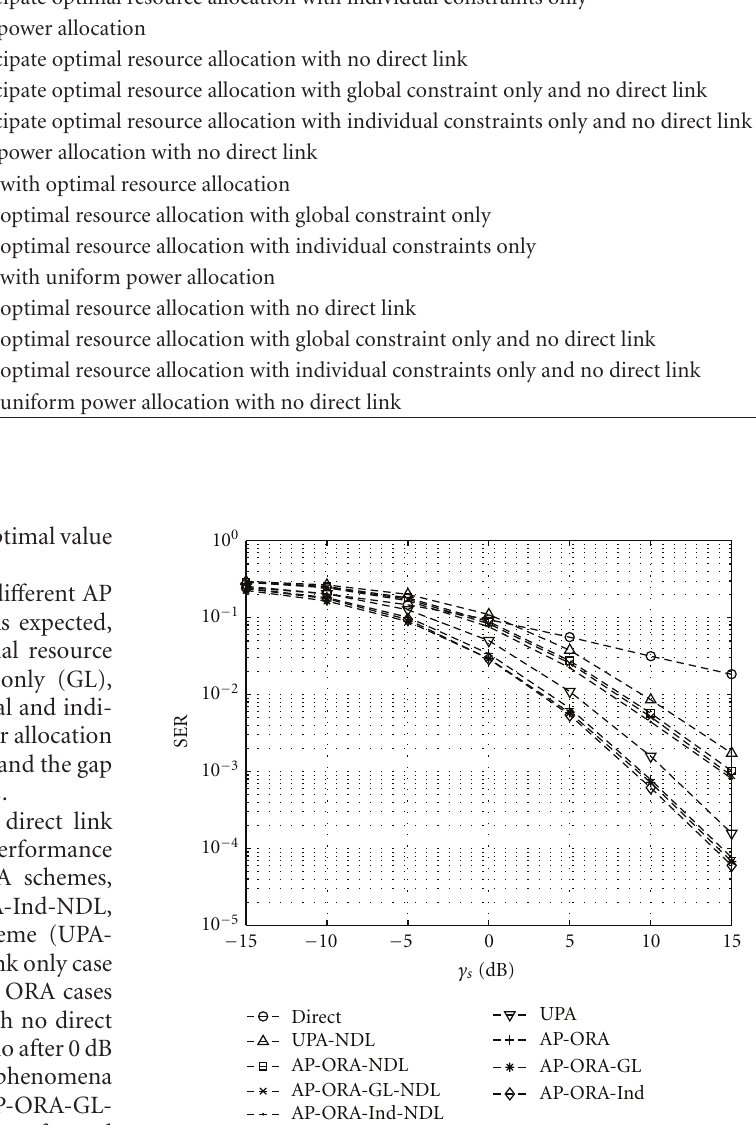
Figure 4: Comparison of SER performance of an all-participate under di ff erent schemes and constraints with m =